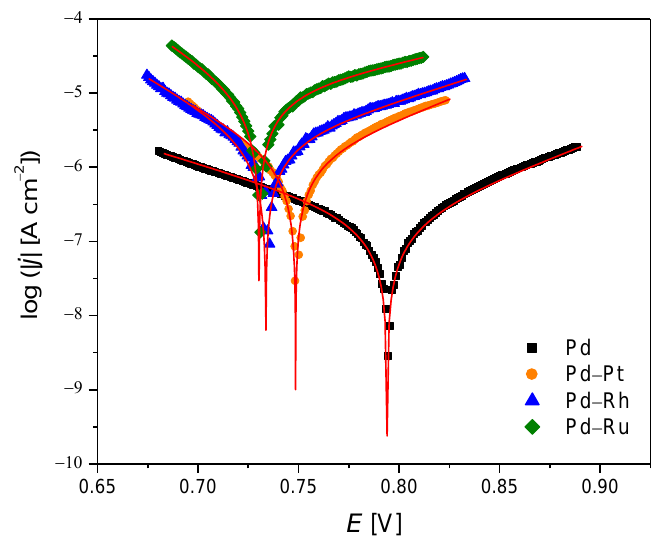
Figure 2. Potentiodynamic polarization curves obtained for electrodeposited Pd, Pd-Rh, Pd-Ru, and Pd-Pt electrodes in deaerated 0.5 M H 2 SO 4 . Symbols and continuous lines represent experimental data and fits obtained using the Butler–Volmer equation, respectively. Table 2. The corrosion resistance parameters for electrodeposited Pd and Pd-binary alloys in de- aerated 0.5 M H 2 SO 4 (see Figure 2).